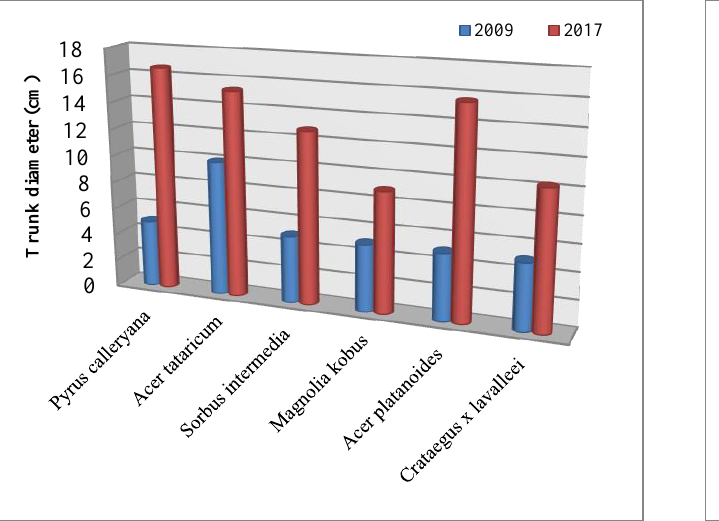
Figure 1. Trunk diameter of six tree taxa in streets of Debrecen in 2009 and 2017.